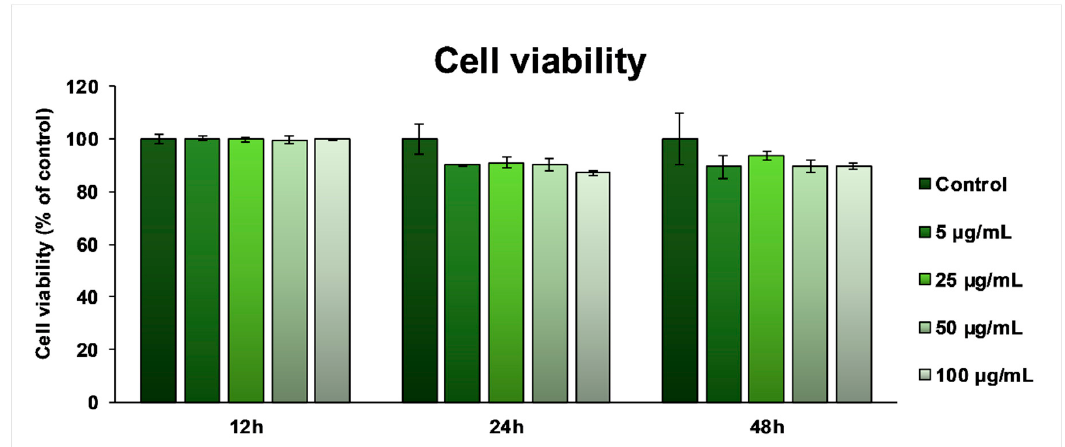
Figure 2. Biocompatibility of Thuja occidentalis MT as shown by cell viability assay after 12, 24, and 48 h incubation of the intestinal Caco-2 cells with different concentrations (5, 25, 50, and 100 μ g/mL) of the selected tincture. Results are expressed as the mean ± standard deviation (SD) ( n = 3) and represented relative to the untreated cells (control).